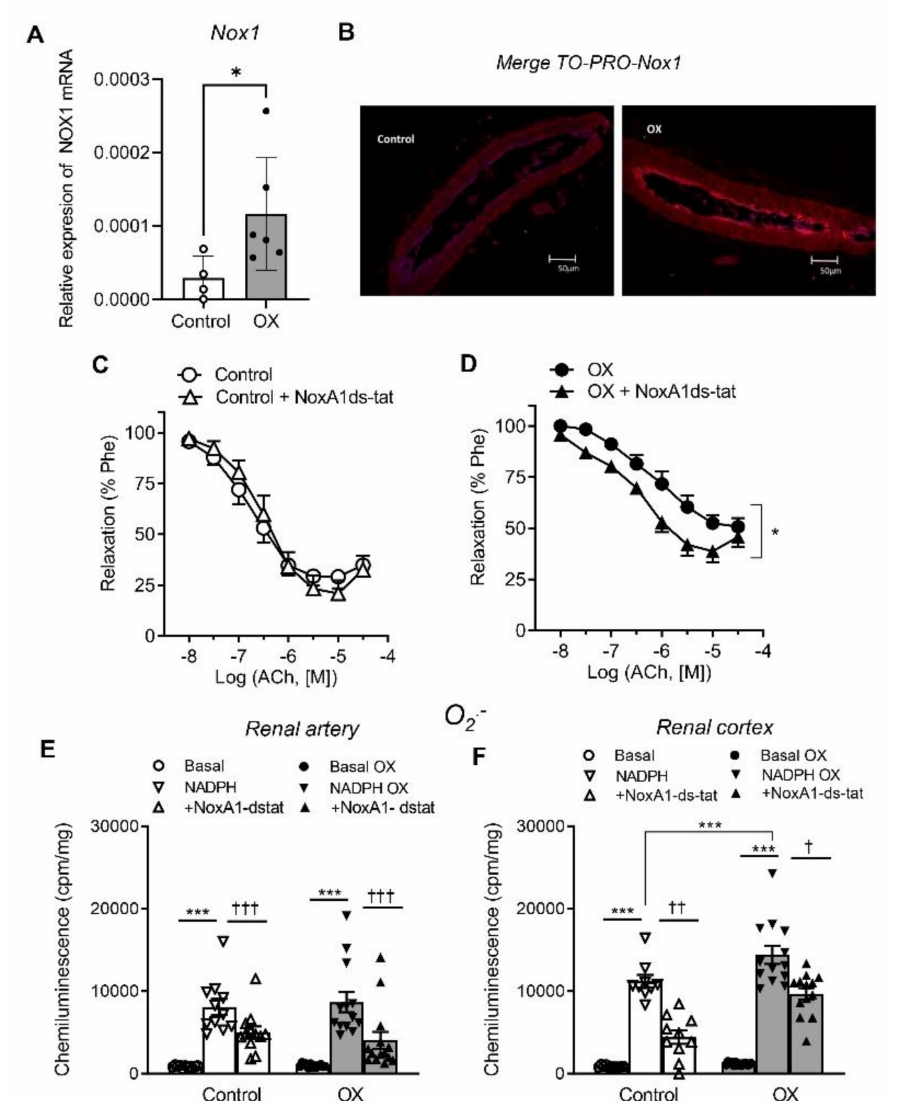
Figure 4. Enhanced Nox1 mRNA expression and amelioration of elevated renal cortex NADPH- dependent O 2 − levels and impaired endothelial relaxations by selective Nox1 inhibition in pre- glomerular arteries from hyperoxaluric rats. ( A ) Comparative Nox1 mRNA expression in samples of renal arteries from the control ( n = 4) and OX group ( n = 6), performed by RT-PCR. The delta CT method was used to determine the fold change for Nox1 gene relative expression in the arteries that were treated with water (control group) and with 0.75% EG (OX group). Statistical differences between means were calculated by unpaired Student’s t -test * p < 0.05. ( B ) Immunofluorescence demonstration of Nox1 subunit protein in a section of a renal interlobar artery. Immunofluorescence double labeling for TO-PRO marker (blue areas) demonstrates nuclear staining and for Nox1 pro- tein (red areas). ( C , D ) Comparative effects of the Nox1 inhibitor NoxA1ds-taT on the endothelial relaxations of rat intrarenal arteries in control ( C ) and OX groups ( D ). Results are given as a percent of the phenylephrine (Phe) contraction as the mean ± SEM of 8 arteries (4 animals). Statistical differences were calculated by an unpaired Student’s t -test *** p < 0.05 (pEc 50 , see Table 2). ( E ) Effects of NoxA1ds-tat on NADPH-dependent ROS generation in renal interlobar arteries and in kidney cortex from control and hyperoxaluric rats. ( F ) measured by lucigenin chemiluminescence. Re- sults are expressed as counts per minute (cpm) per mg of tissue. Bars represented mean ± SEM of 5–10 animals. Statistical differences were calculated with t -test *** p < 0.001, versus basal levels. † p < 0.05, †† p < 0.01; ††† p < 0.001 versus